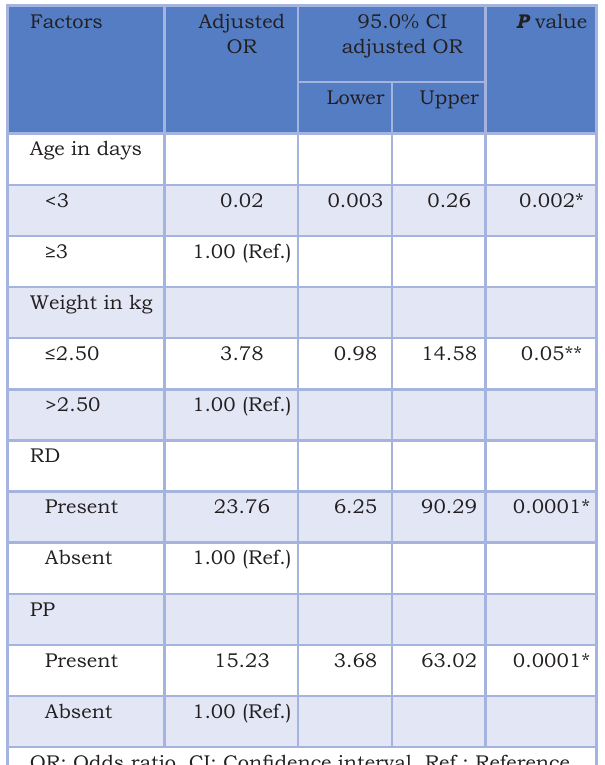
Table 3: Factors associated with requirement of ventilator in post-operative period-Multivariate logistic regression